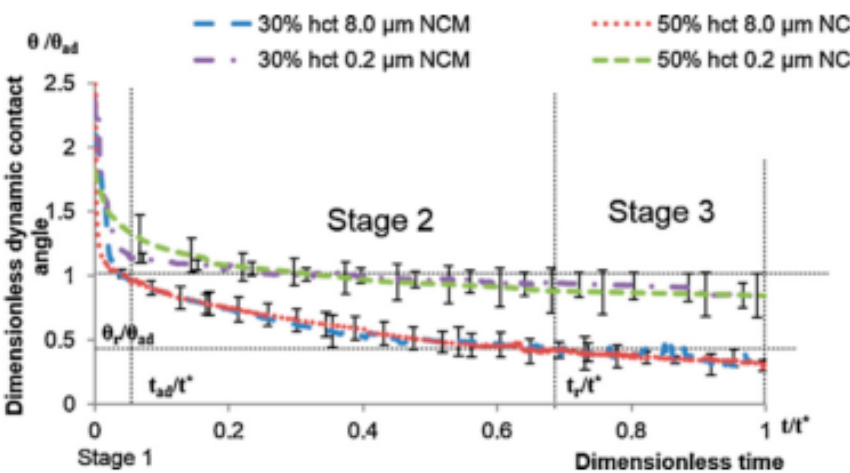
Figure 8. Dimensionless radius of contact angle in the case of spreading of blood droplets over nitrocellulose membrane. In the case of 0.2 µm membrane pores there is no stage 3, it is a continuation of stage 2. The contact angle remained almost constant value after stage 1 [38].